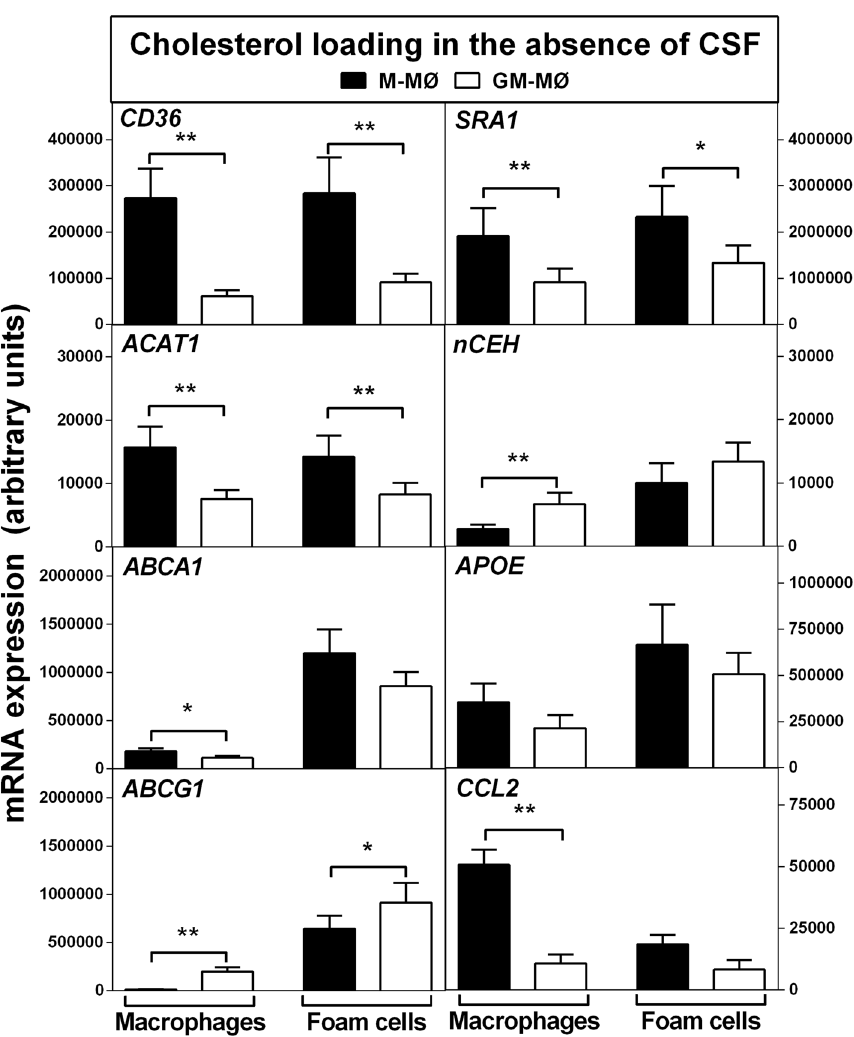
Figure 1. Expression of genes responsible for cholesterol accumulation and inflammation in M-CSF or GM-CSF-polarized macrophages before and after their conversion into foam cells in the absence of CSF. Gene expression levels were determined by quantitative RT-PCR in M-MØ and GM-MØ before (Macrophages) and after (Foam cells) cholesterol loading with acetyl-LDL (25 µg/mL). Data are presented as means ± SEM of 10 individual blood donors and triplicate incubations for each studied gene. *p < 0.05 and **p < 0.01 denote statistically significant difference between the expression levels in M-MØ and GM-MØ, both before and after cholesterol loading, by Wilcoxon Signed-Rank test for paired